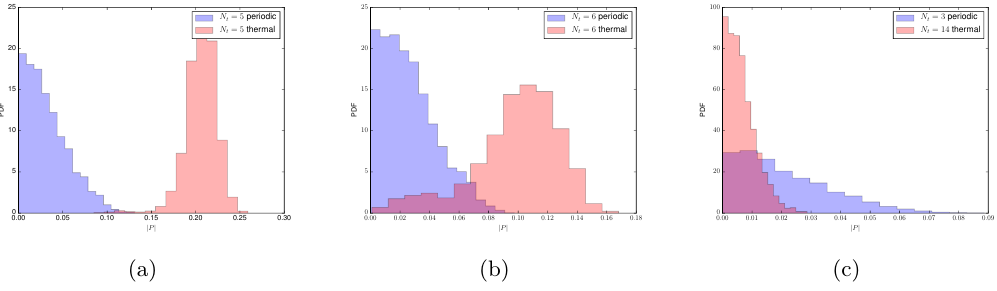
Figure 5 . The histograms for the Polyakov loop at selected N t = R/a for periodic and thermal fermion boundary conditions. The parameters are the same as in figure